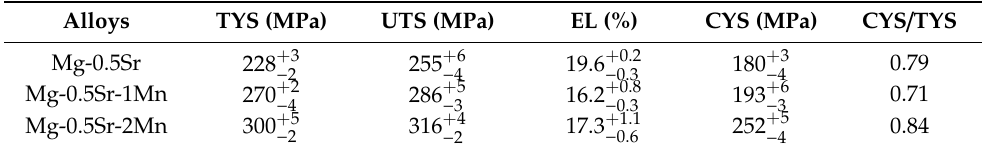
Table 2. Mechanical properties of as-extruded Mg-0.5Sr-xMn alloys with di ff erent Mn (x = 0, 1, and 2 wt.%).